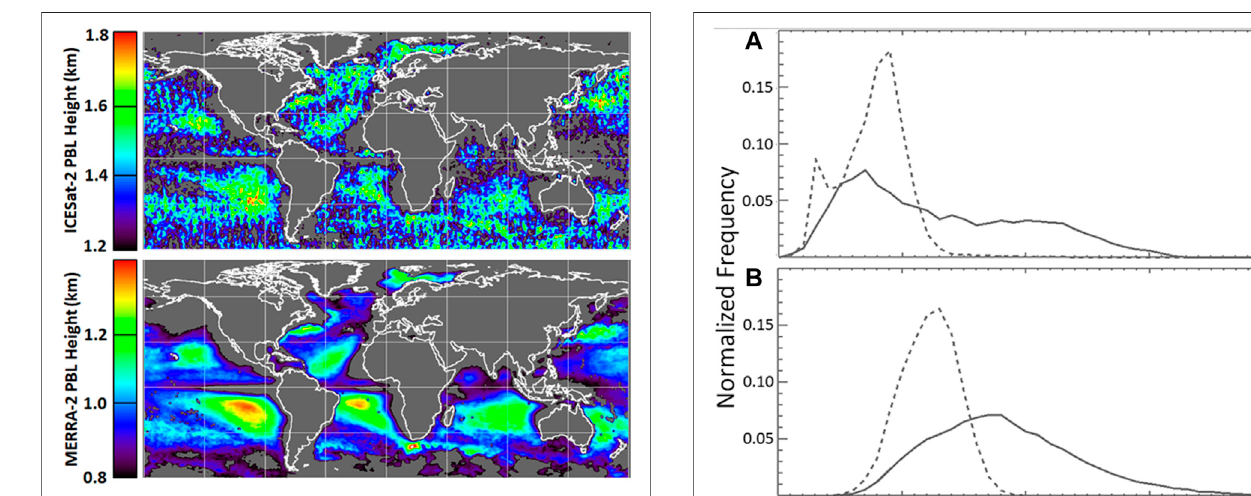
FIGURE 8 | 2019 oceanic PBL height for ICESat-2 (top) and MERRA-2 (bottom). Note that each are scaled differently to bring out the correlation between the two PBLH results. FIGURE 9 | (A) MERRA-2 ocean (dashed) and land (solid) PBL height